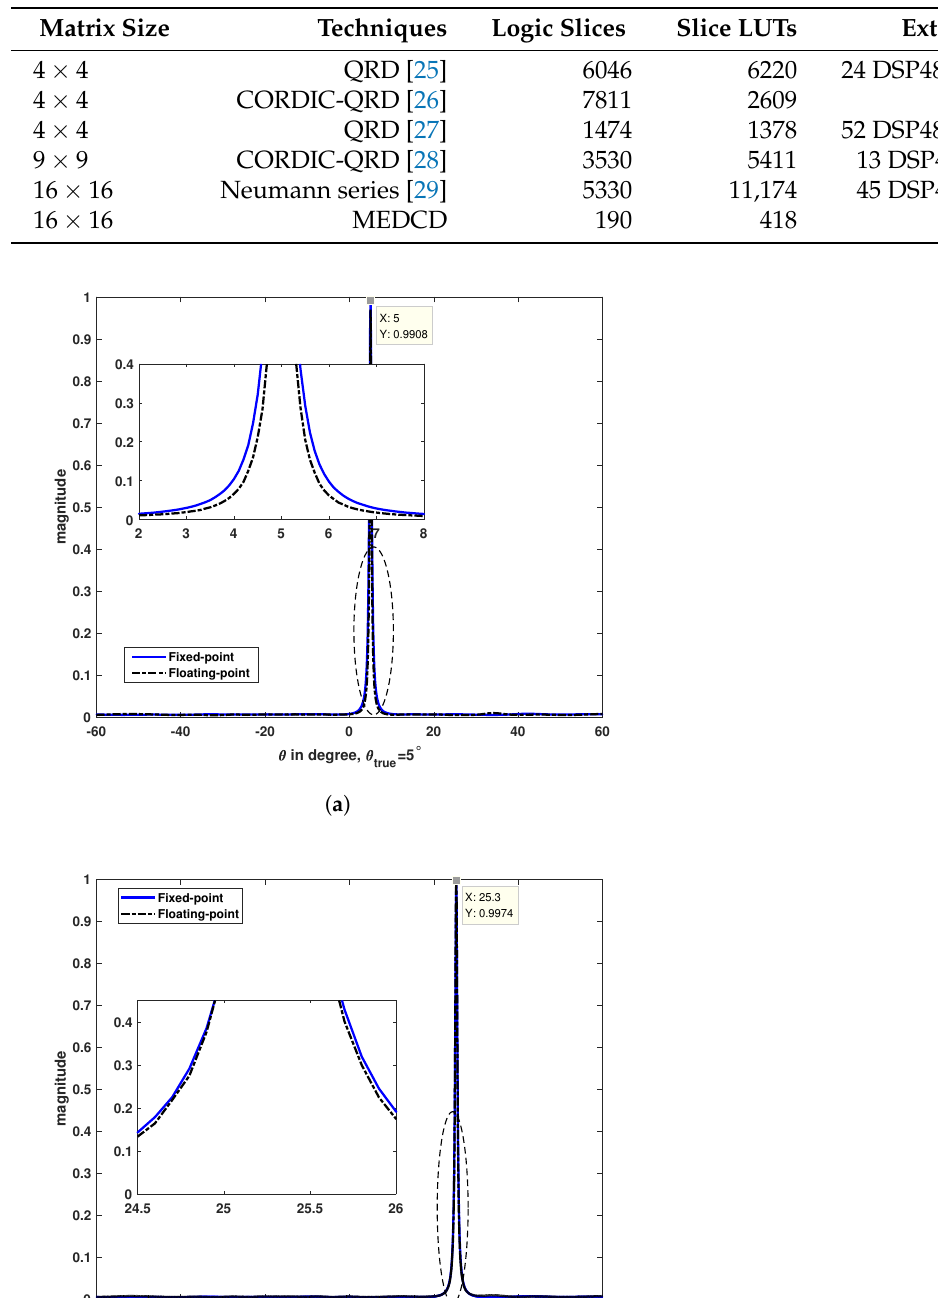
Table 5. Comparison of FPGA based matrix inversion techniques.